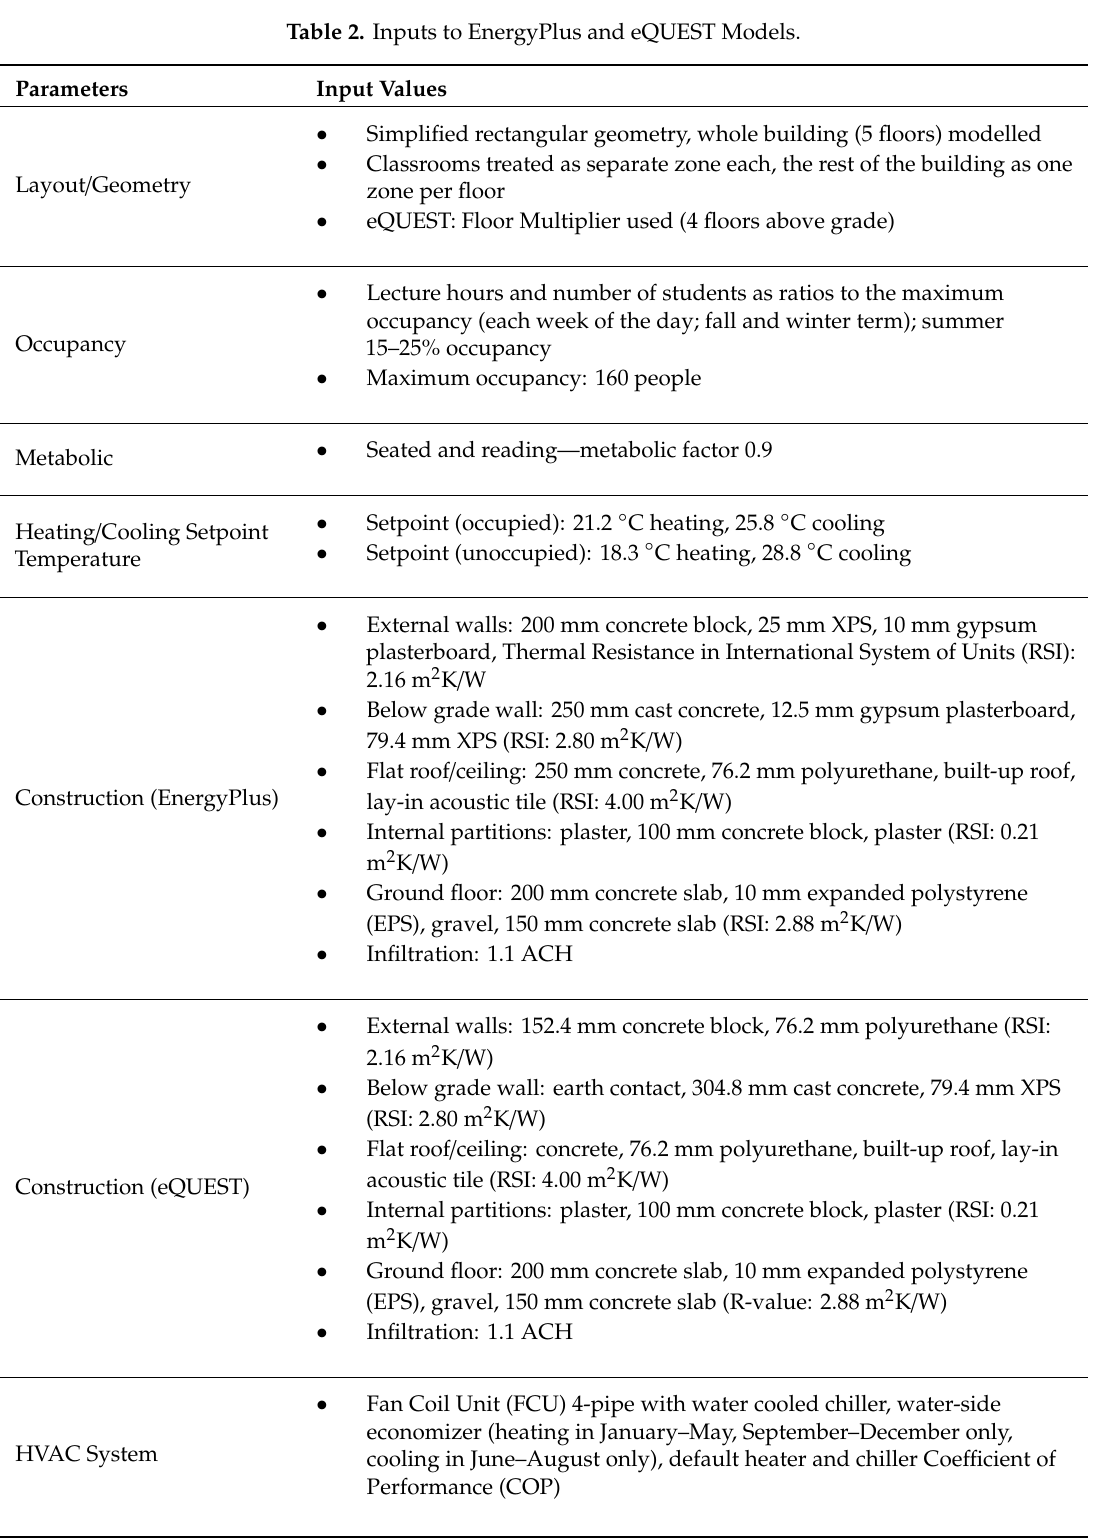
Table 2. Inputs to EnergyPlus and eQUEST